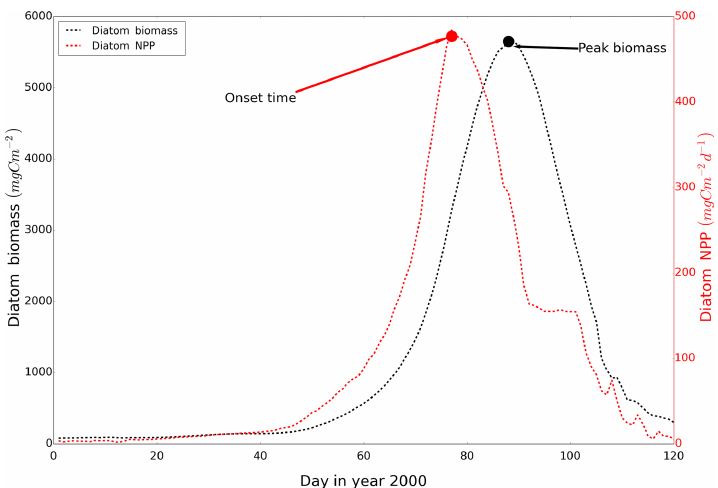
Figure A2. The definition of onset time of the spring bloom. The dashed black line is the time series of diatom biomass and the dashed red line is the time series of NPP. Both time series have undergone a 15d running average. The black arrow depicts the time when the spring bloom reaches its maximum biomass. The red arrow depicts the time when the NPP reaches its maximum prior to biomass peak, which is defined as the onset time of the spring bloom. The time series is extracted from a grid cell (56 ◦ N, 4.2 ◦ E) from the ECOSMO simulation, for the year